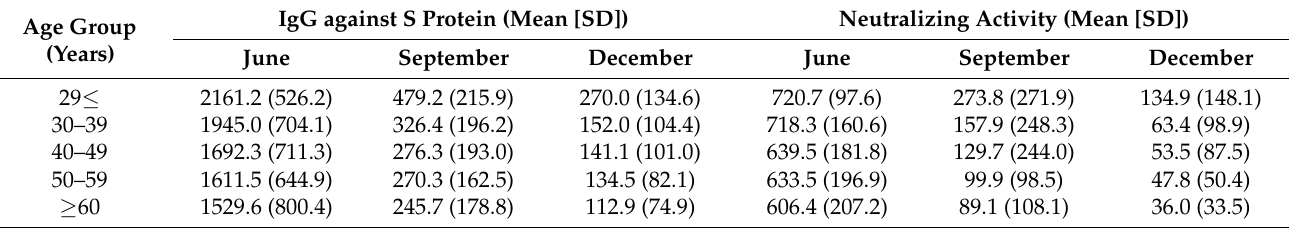
Table 2. Mean of antibody titer by age groups (N = 205).